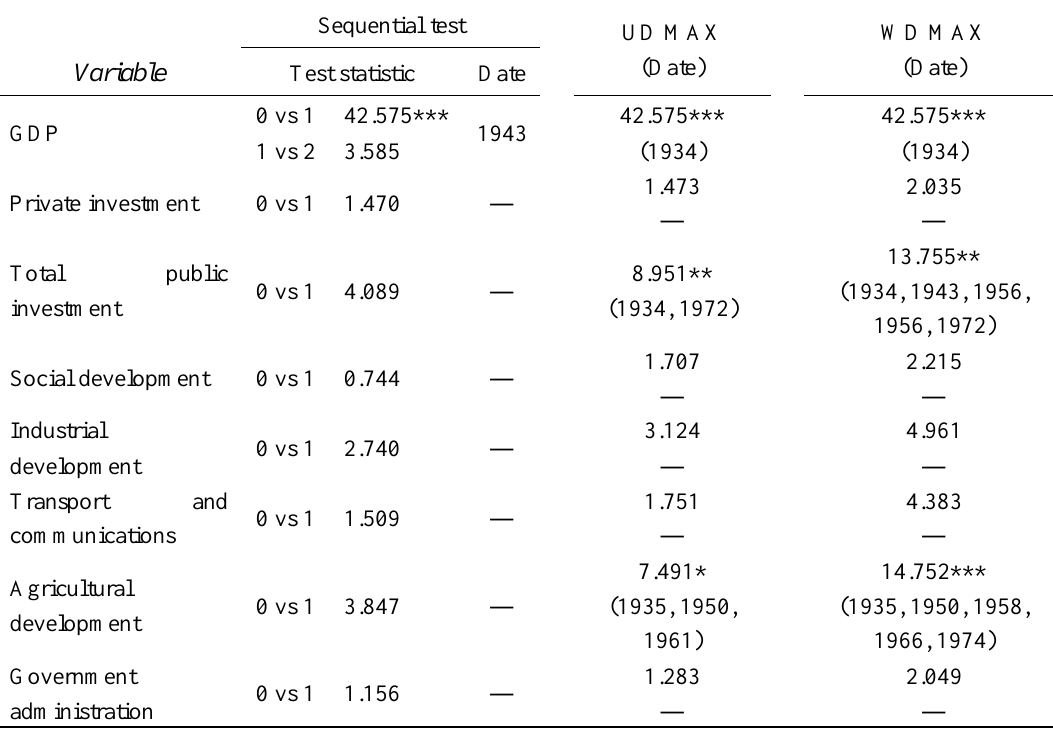
Table A1 : Results of the Bai and Perron